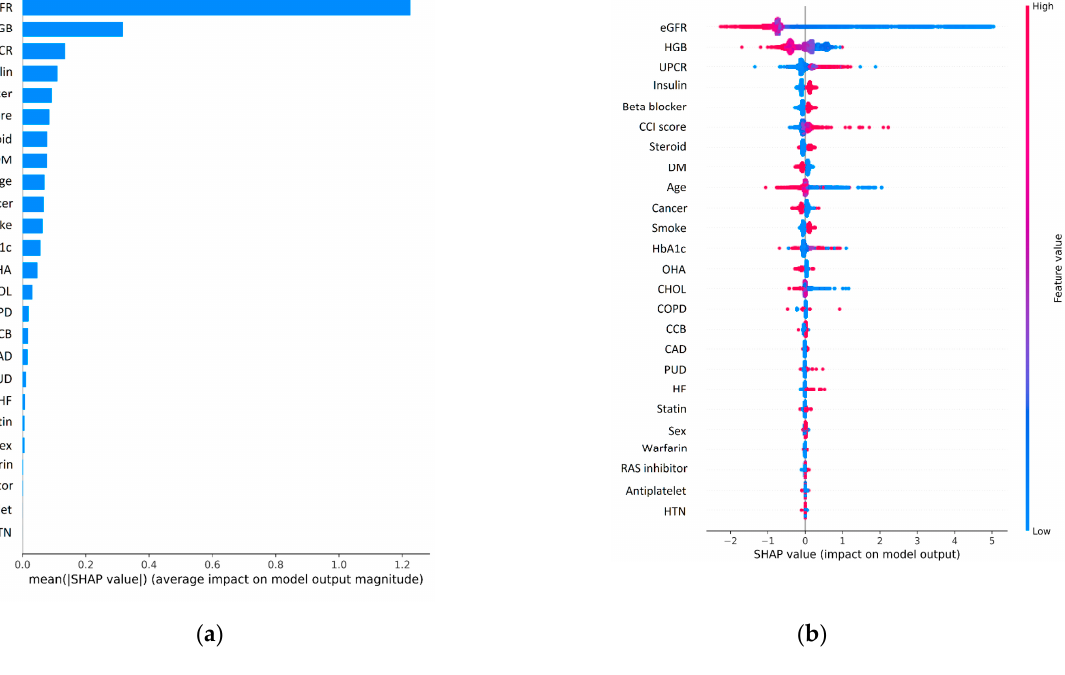
Figure 3. Feature importance plot ( a ) and SHAP summary plot ( b ) of the top 25 clinical features predict end-stage renal disease development in the GBDT model. Abbreviations: eGFR—estimated glomerular filtration rates; HGB—hemoglobin; UPCR—urine protein/creatinine ratio; CCI—Charlson comorbidity index; DM—diabetes mellitus; HbA 1C —glycohemoglobin; OHA—oral hypoglycemic agents; CHOL—cholesterol; COPD—chronic obstructive pulmonary disease; CCB—calcium channel blockers; CAD—coronary artery disease; PUD—peptic ulcer disease; HF—heart failure; RAS—renin–angiotensin system; HTN—hypertension.